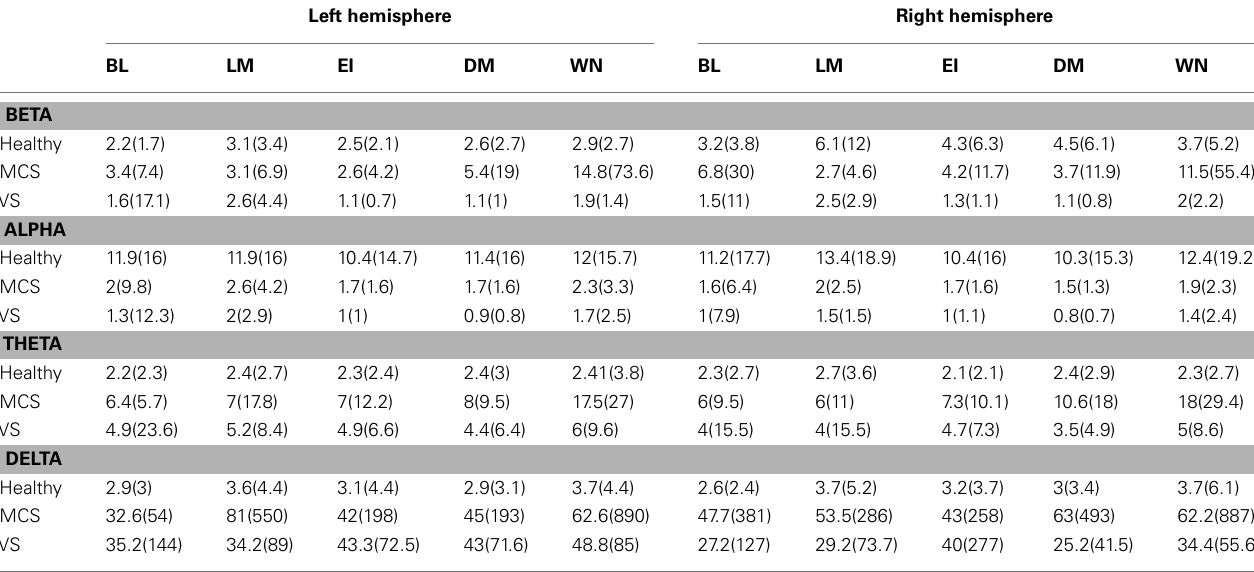
Table 2 | Electroencephalogram mean amplitude ( µ V): stimuli